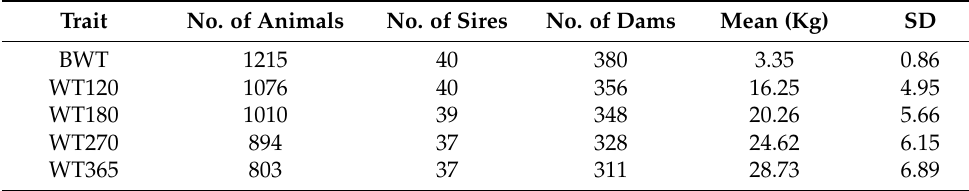
Table 1. Descriptive statistics of growth traits of Lohi